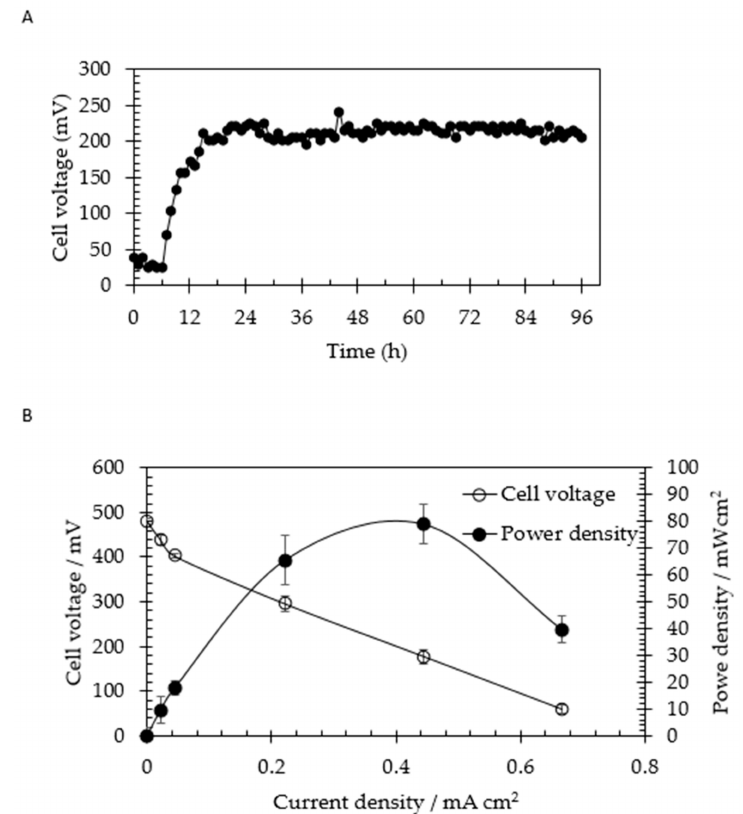
Figure 2. Bioelectricity generation from commercial starch by Clostridium beijerinckii SR1. ( A ) Voltage generation from 10 g / L of starch by C. beijerinckii SR1 as a function of time. ( B ) Power density and cell voltage generation as a function of current